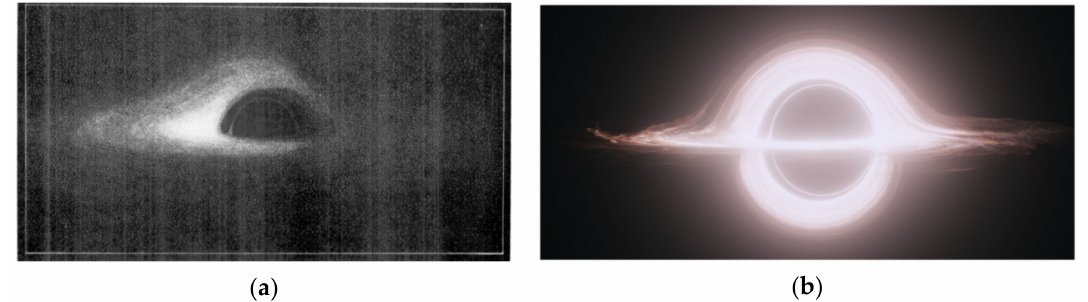
Figure 3. Black hole images made with a theory-based prediction: ( a ) First black hole image [23] (Luminet, J.-P, A&A, 75, 235, 1979, reproduced with permission © ESO); ( b ) Black hole image in the film Interstellar [25]. The upper part of the figure represents the primary image of the disk and the lower part shows the secondary